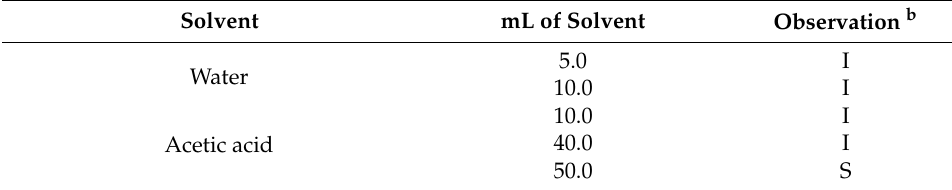
Table 5. Solubility characteristics of jojoba oil in common organic solvents at 15 ◦ C a